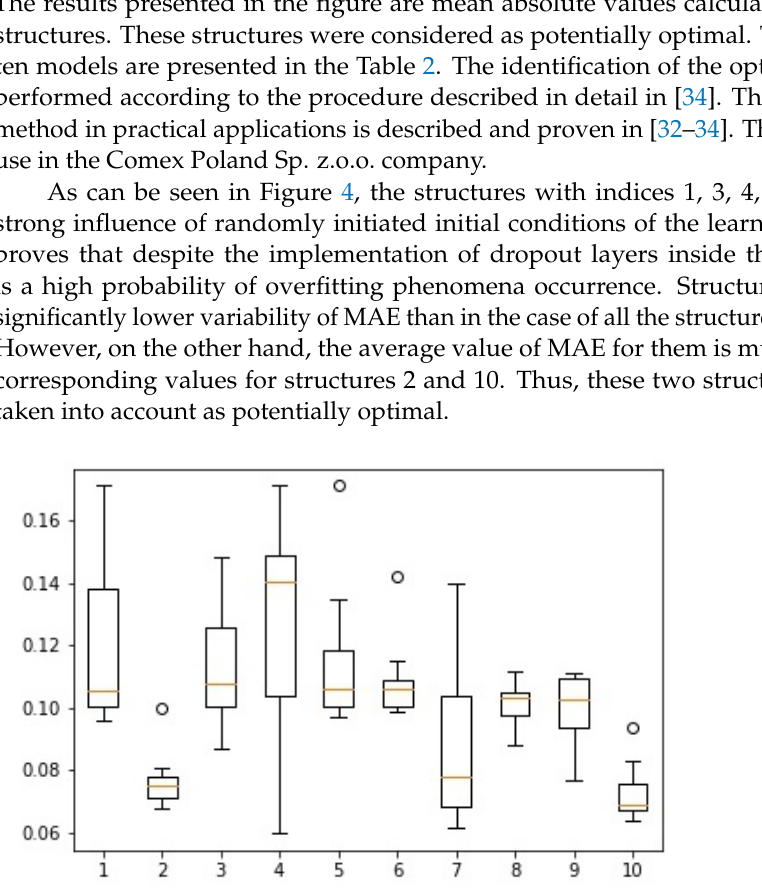
Figure 4. Boxplots of the mean absolute error values from tests stage, obtained for the 10 best structures selected from the result of the optimization procedure. Table 2. Main characteristics of 10 potentially optimal